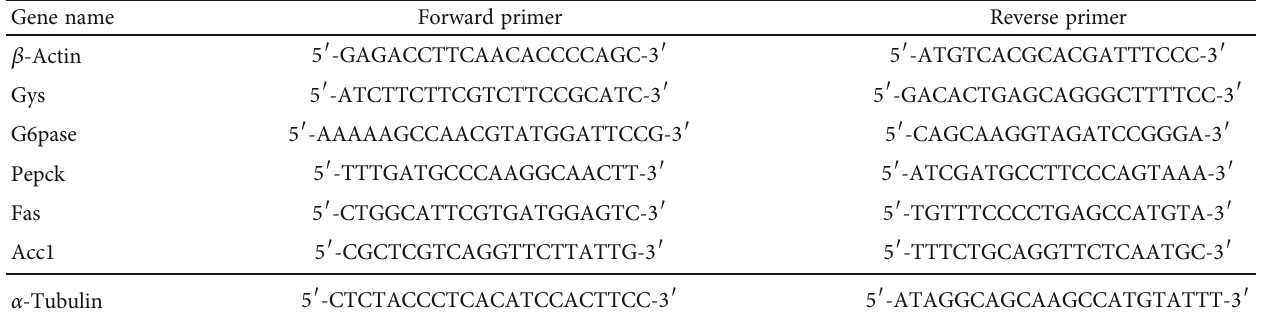
Table 1: Gene sequences of